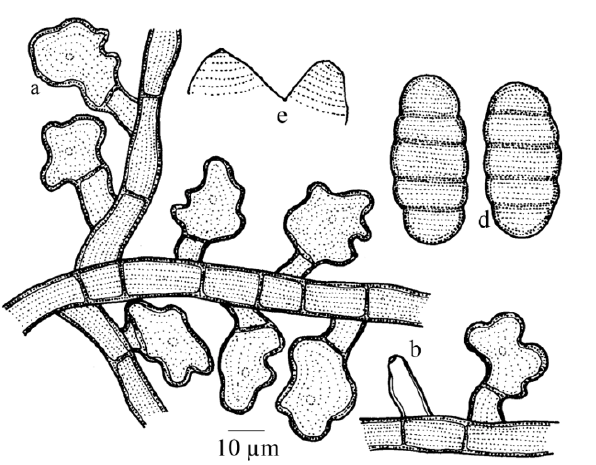
Figure 14. Asteridiella americana a - Appressorium; b - Phialide; d - Ascospores; e - Perithecial wall cells